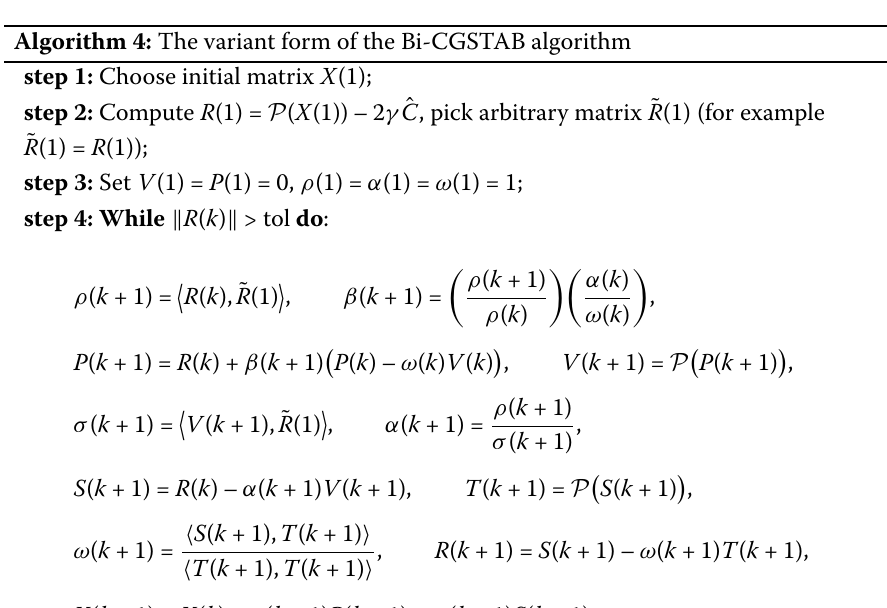
Algorithm 4: The variant form of the Bi-CGSTAB